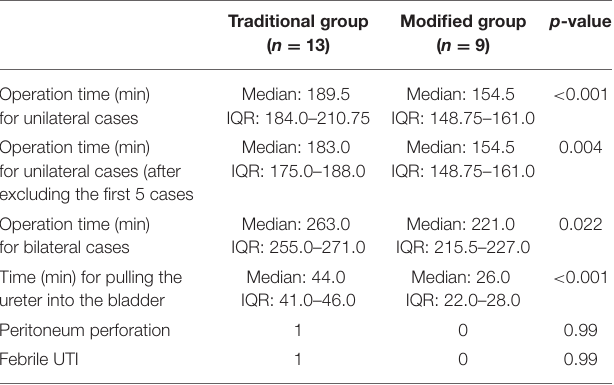
TABLE 2 | Treatment outcomes for each group.